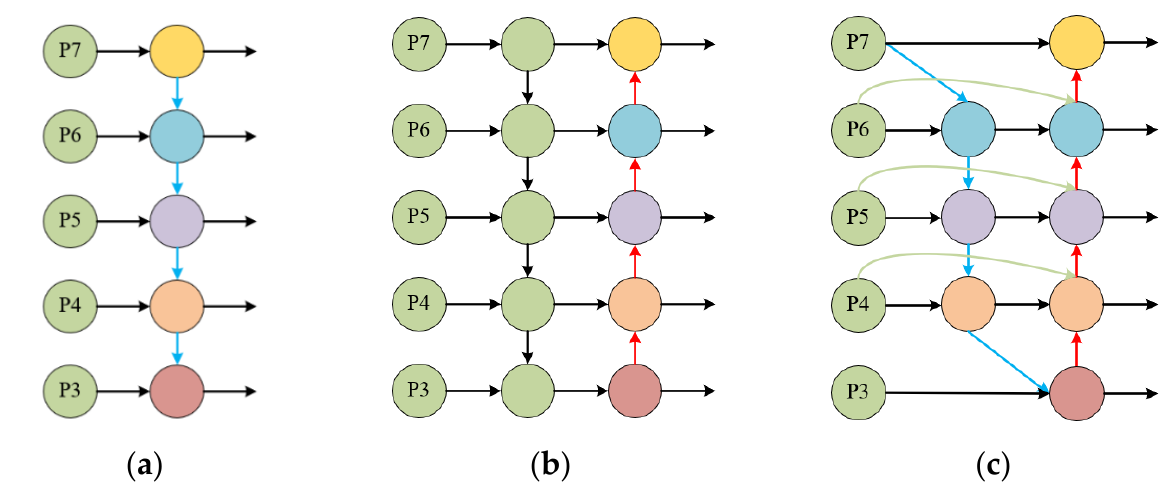
Figure 3. Comparison of three feature fusion networks. ( a ) FPN introduces a top-down pathway to fuse multi-scale features from P3 to P7; ( b ) PANet adds an additional bottom-up pathway on top of FPN; ( c ) BiFPN with better accuracy and efficiency trade-offs.